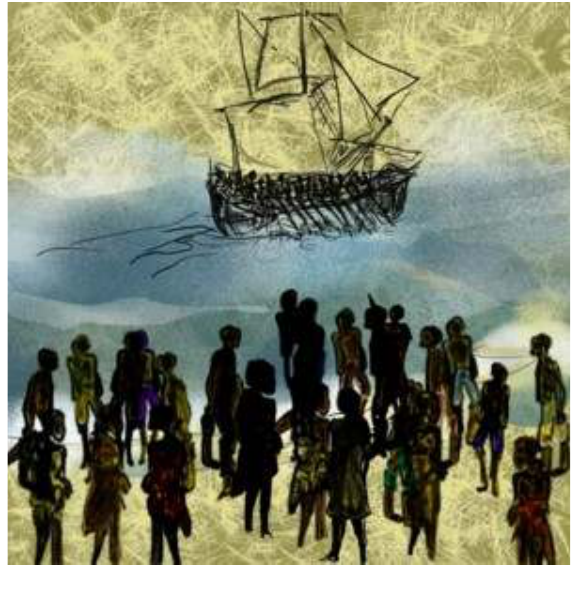
Figure 2. Sylvain Savoia, Les Naufragés de Tromelin , Paris, Aire Libre,